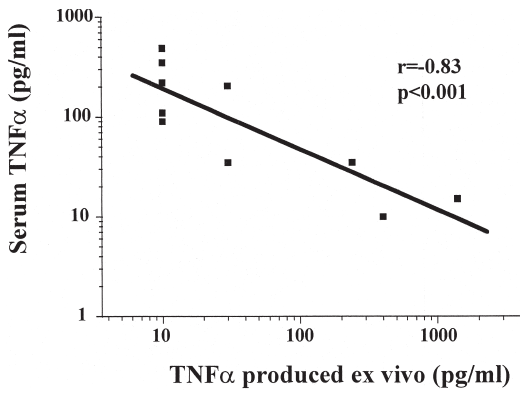
Figure 1 Correlation between serum concentrations of TNF α and TNF α produced ex vivo by LPS-stimulated blood of pa- tients with septic shock. Serum TNF α was measured by ELISA. TNF α produced ex vivo by whole blood stimulated with LPS was measured by